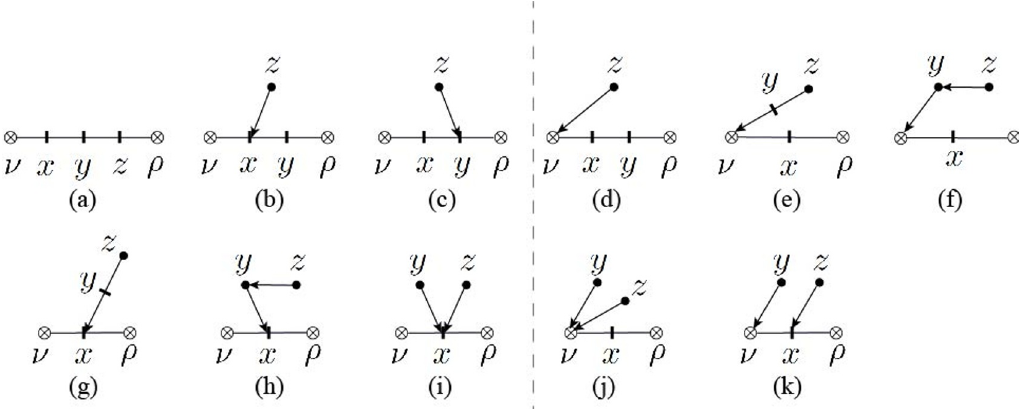
Figure 6 . Type-C graphs with two on-shell nodes.